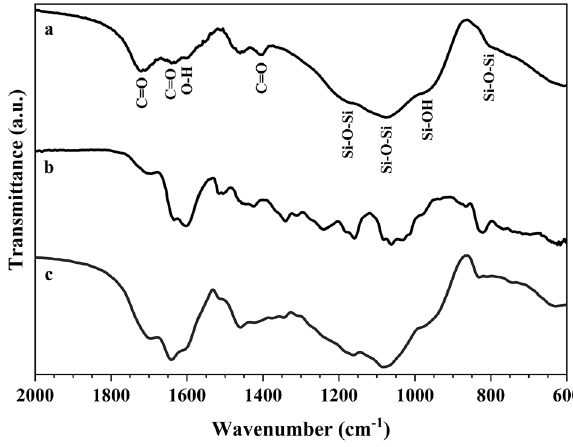
Figure 2. ATR-FTIR spectra of: ( a ) GIC, ( b ) BPE, and ( c ) GIC-BPE.